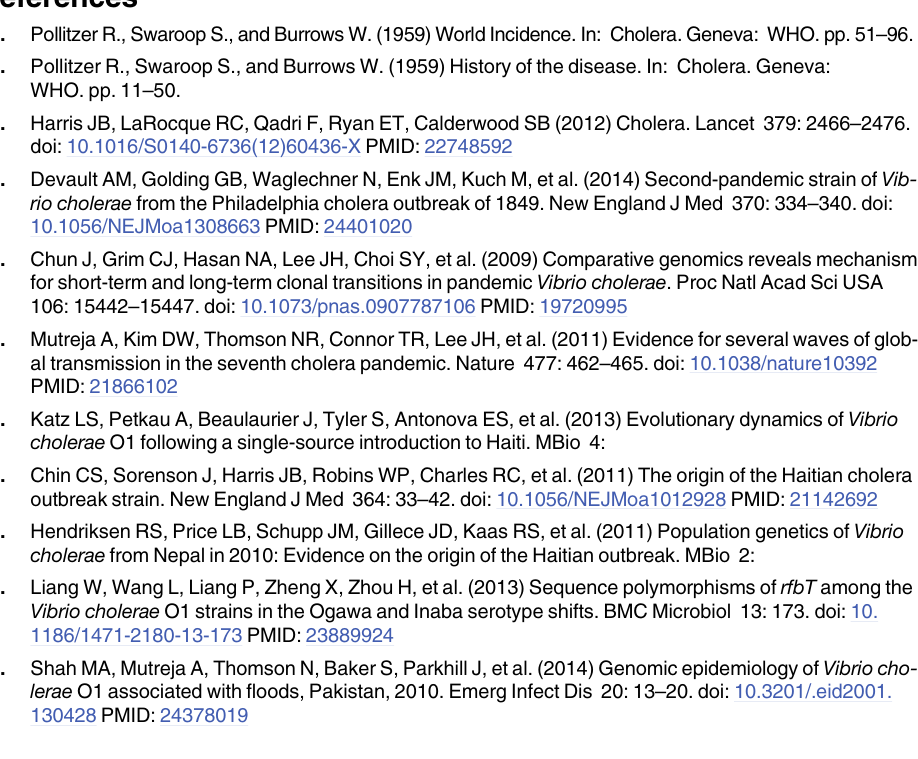
S1 Table. List of genomes used in this study. Part A: list of 260 genomes used in Fig. 3, in the same order from top to bottom. Part B: list of 19 genomes used in Fig. 2, in the same order from top to bottom. S2 Table. Mutation rates measured experimentally for 79 strains. S3 Table. Variations in genes of the mismatch repair system among 17 genomes with long branches. S4 Table. Summary of the 18 unambiguous international migration events reconstructed by maximum parsimony, including their source (row), destination (column) and estimated date (in